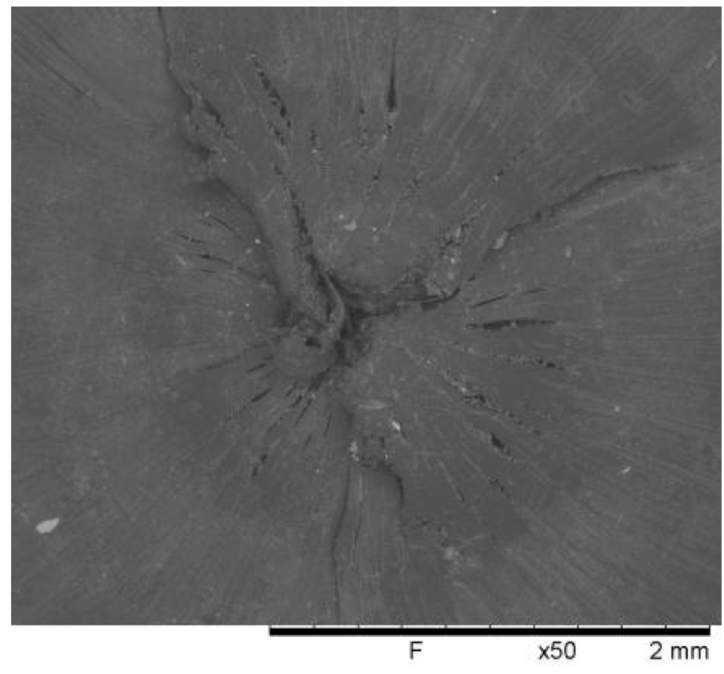
Figure 13. SEM image of the projectile exit side of a healed ionomeric tank wall (water